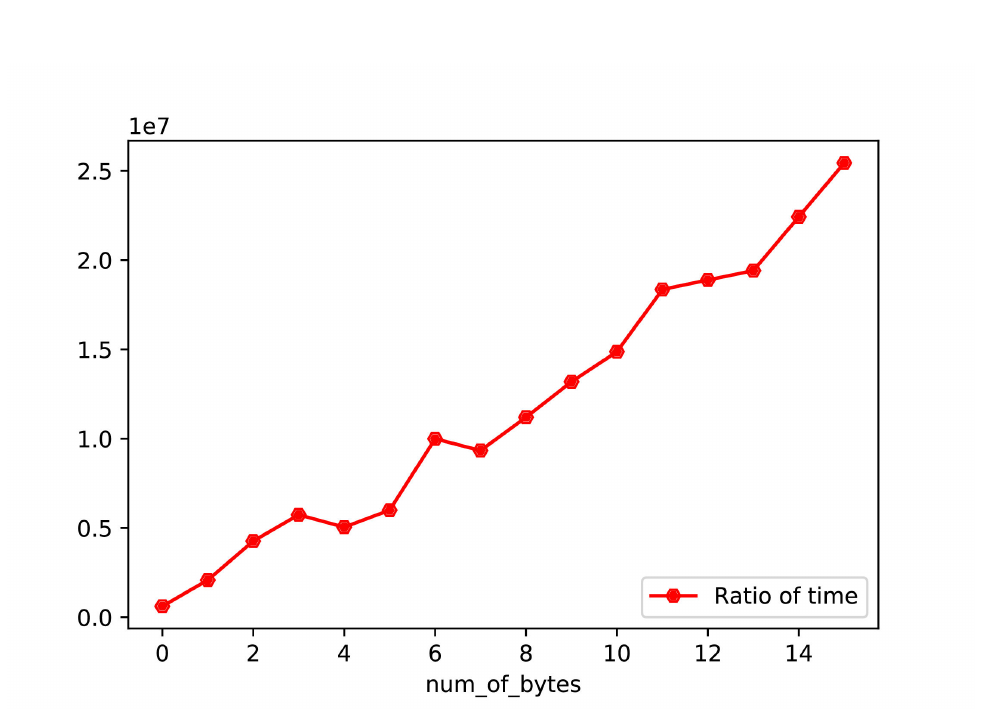
Figure 4: Ratio of time for PS-TH-GE and GEEA to reach the same accuracy.